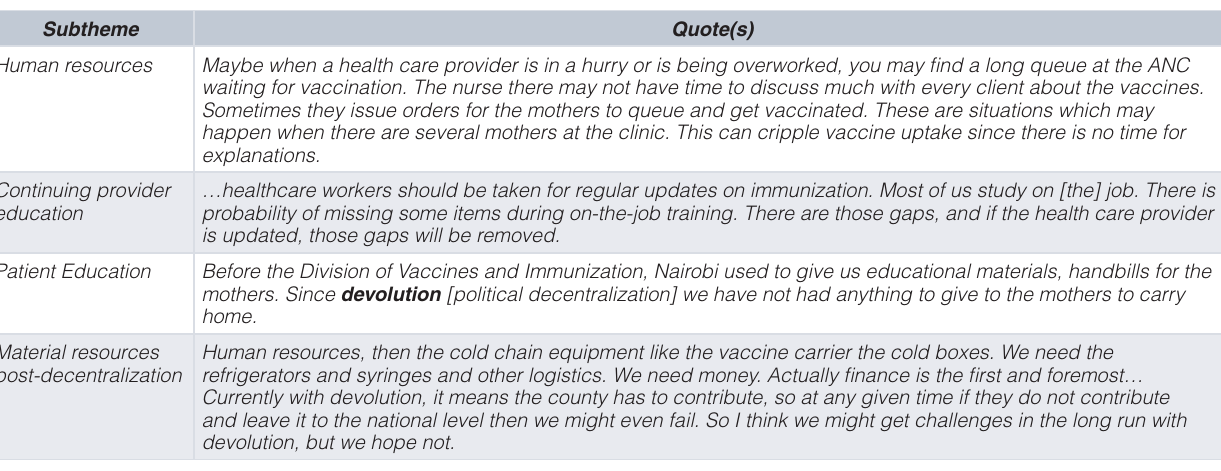
Table 3. Resources needed for improved vaccine delivery.